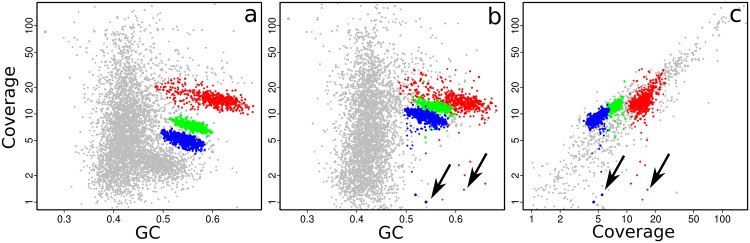
Coverage-GC plots (a,b) and differential coverage plot (c) of an O. algarvensis metagenome, illustrating the appearance of manually defined genome bins (colored overlays) from Figure 3c: (a) with the original coverage data, (b) with coverage data from a different read library, and (c) when the two sets of coverage data are plotted against each other. Contigs with GC <45% were omitted from (c) for clarity, as they are mostly from the host animal genome. Arrows indicate contigs which were included in the originally defined bin but have low coverage in another read library, suggesting that they may be contaminant sequences or strain variation.